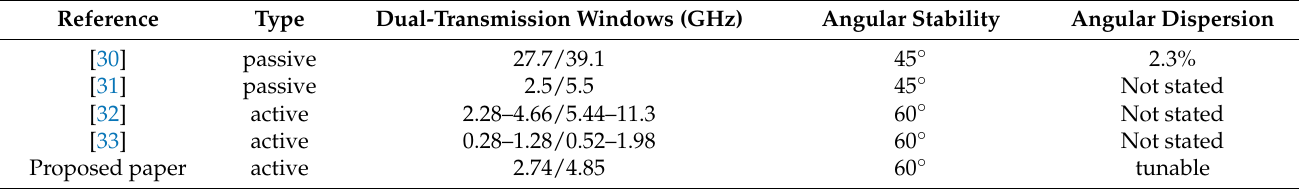
Table 3. Comparison with the meta-devices for dual-transmission